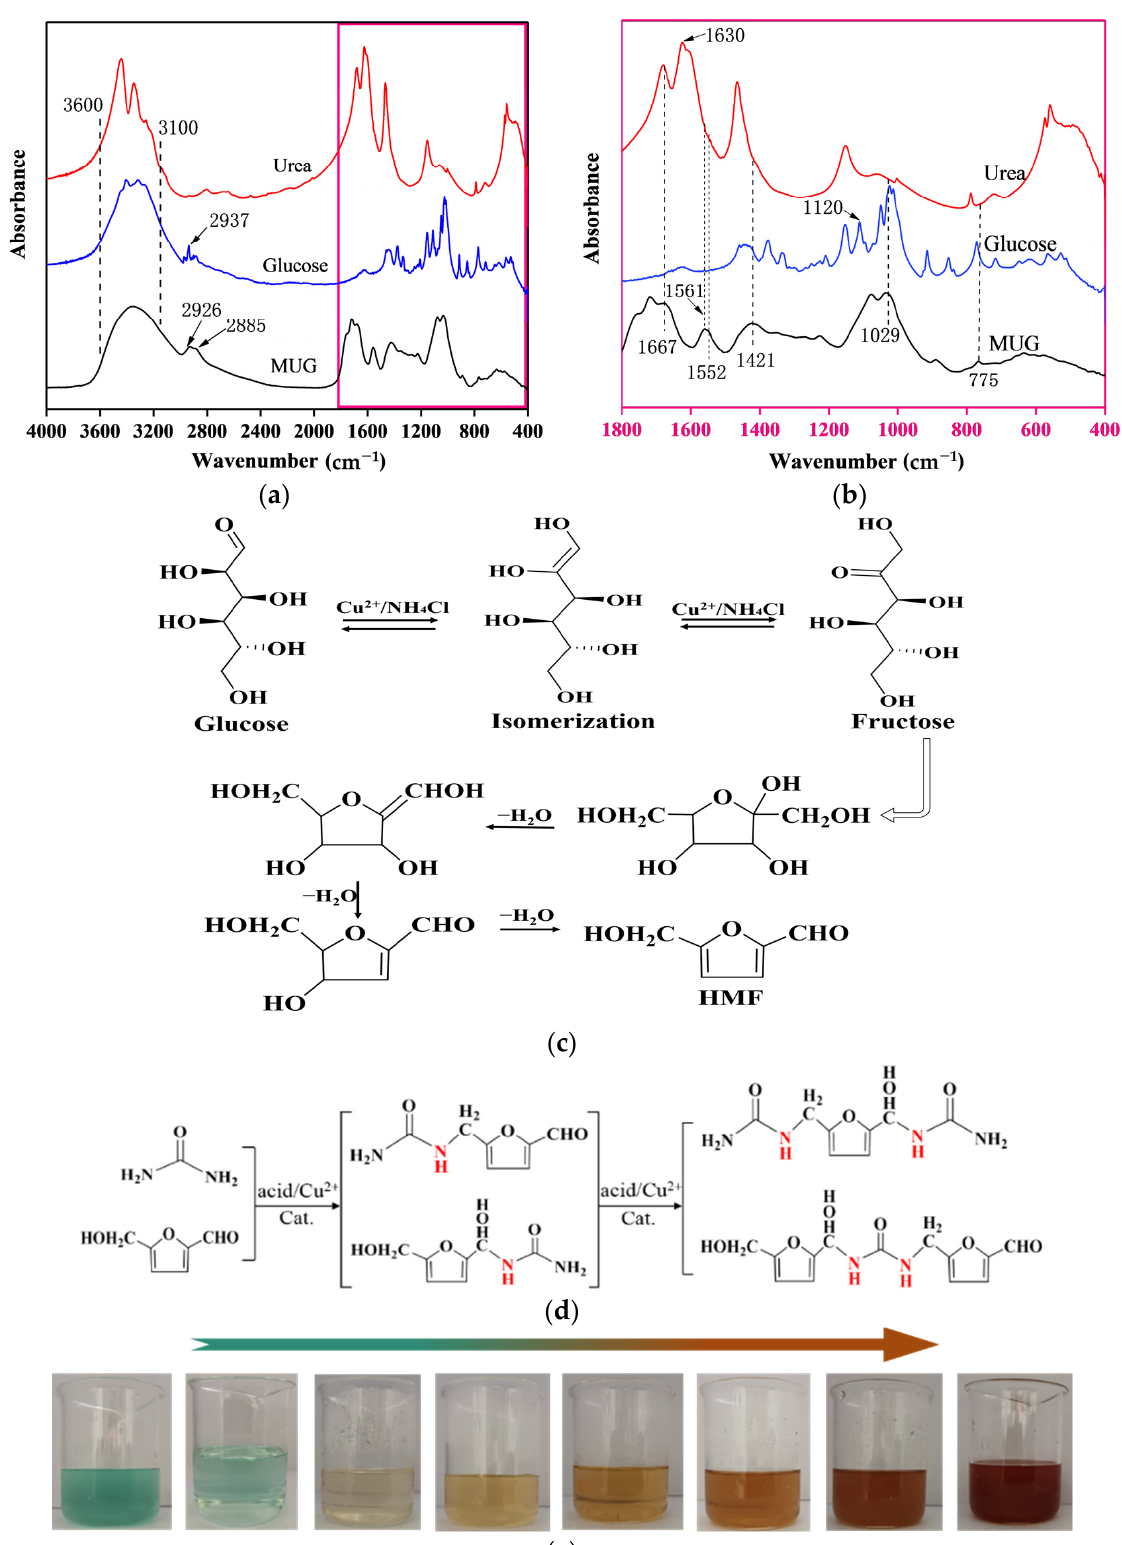
Figure 1. Schematic illustration of: ( a , b ) Infrared spectrum image of resin, ( c ) the reaction process of glucose isomerization- dehydration to form 5-HMF, ( d ) synthetic mechanism of linear glucose-urea-melamine (MUG) resin, ( e ) color change during resin synthesis.